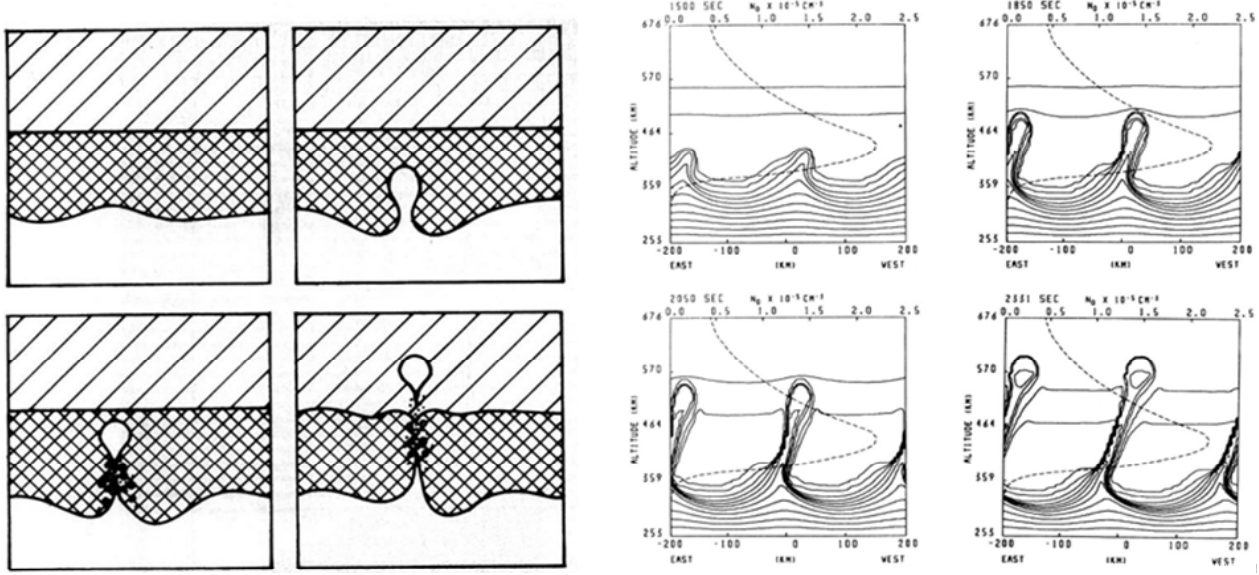
Fig. 8. The left panel shows a Woodman and La Hoz (1976) sketch of how a low density bubble propagates to the stable top provided that the densities there are higher than those in the lower third. The right panel shows the result of a computer simulation by Zalesak et al. (1982) of the same. The westward tilt reproduces the tilt of the plumes and is produced by a eastward neutral wind, also in accord with the Woodman and La Hoz (1976)